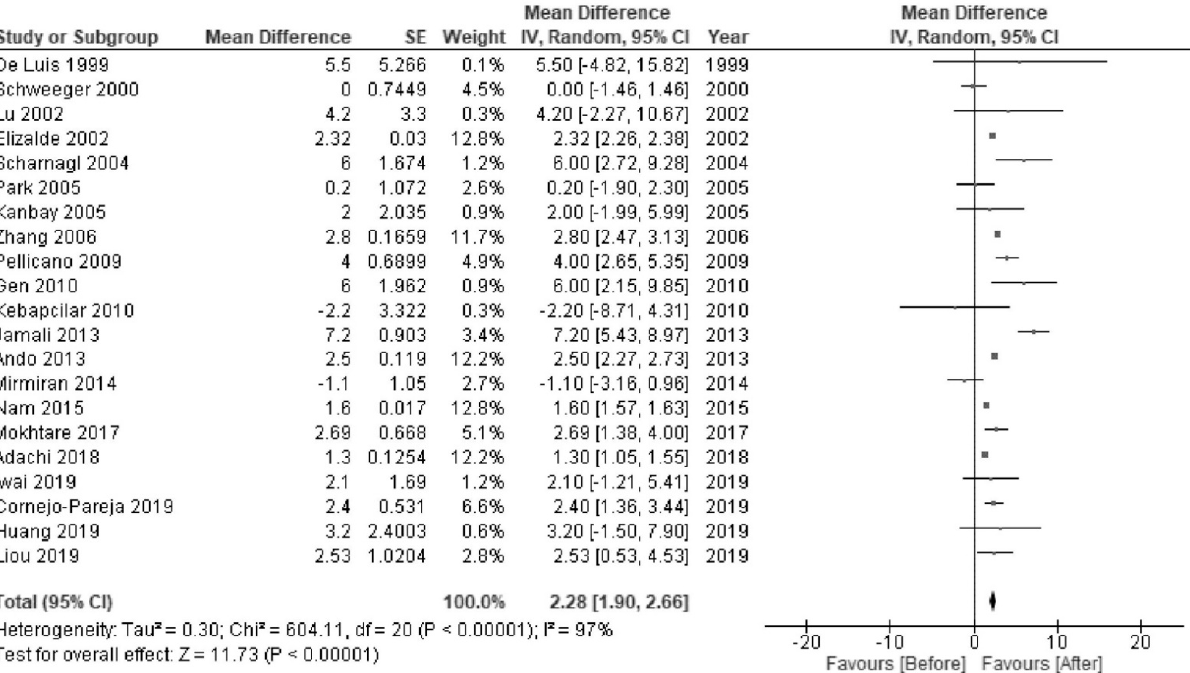
Figure 2. Forest plot of the mean changes in high-density lipoprotein cholesterol levels before and after Helicobacter pylori eradication.